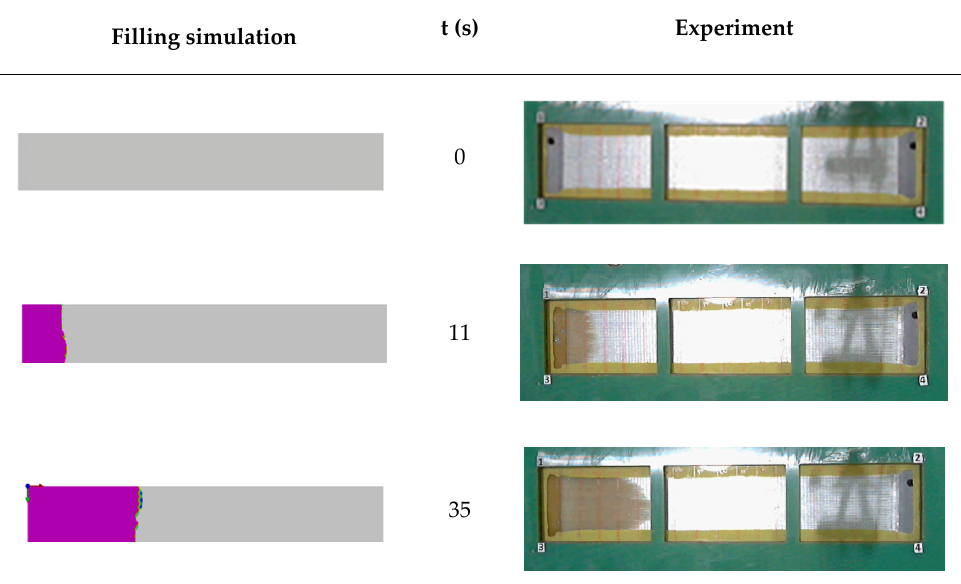
Figure 8. Leaf spring RTM process simulation.